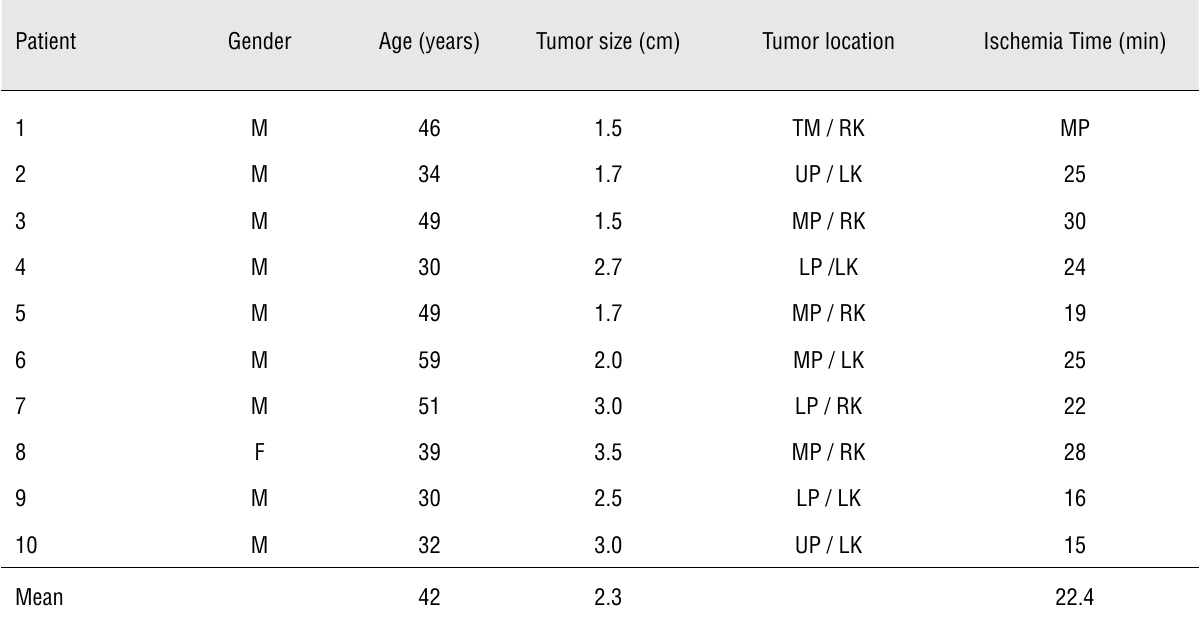
Table 1 – Patient demographics, renal functional outcomes and warm ischemia time